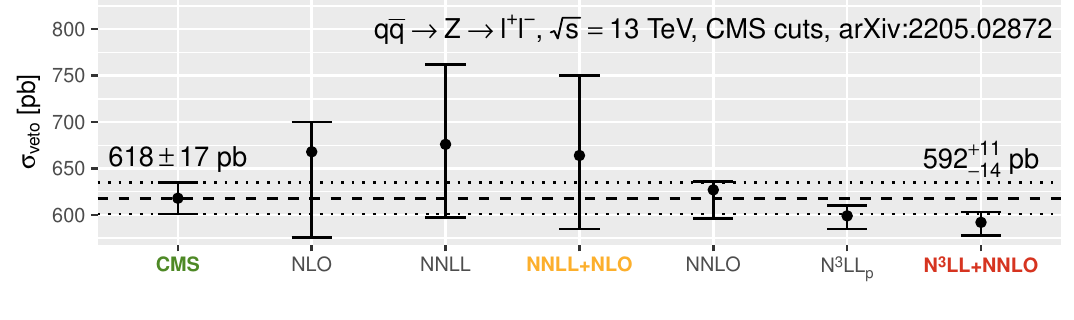
Figure 10 . Comparison of Z -boson jet-vetoed predictions with the CMS [38] 13 TeV measurement. Shown are results at fixed-order, purely resummed and